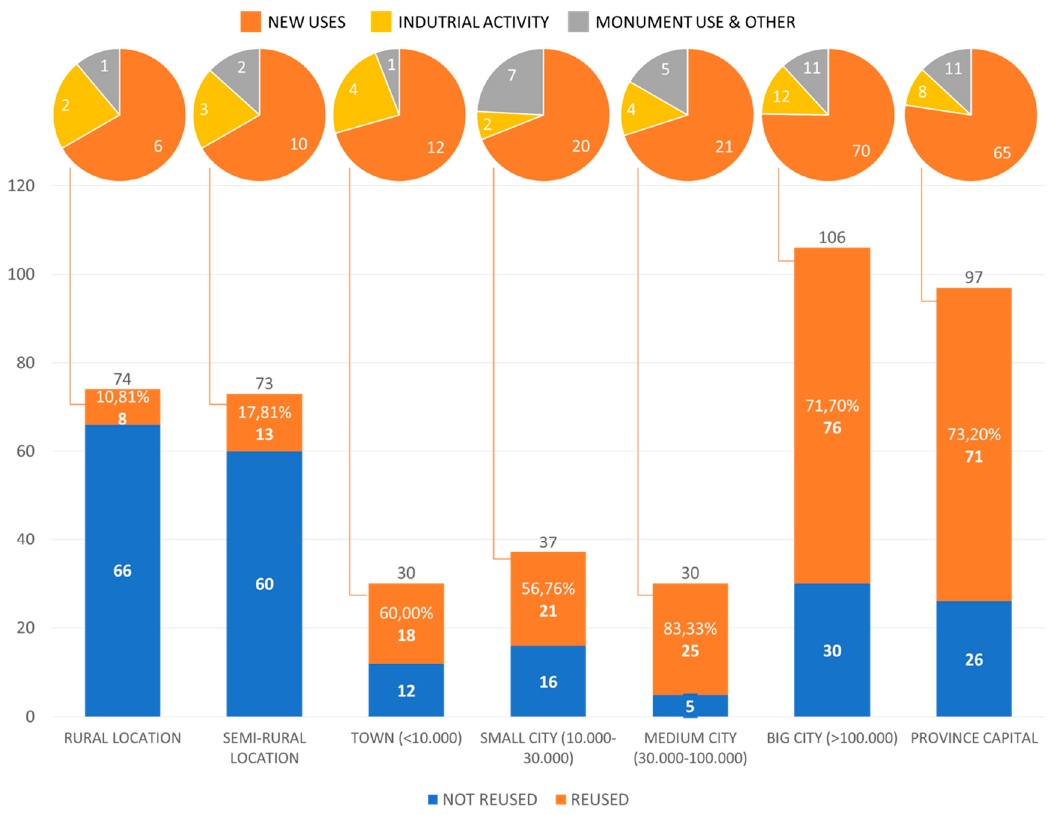
Figure 14. Assets reused and not reused for each classification category referred to the relation with the local population. New uses are of a general nature.